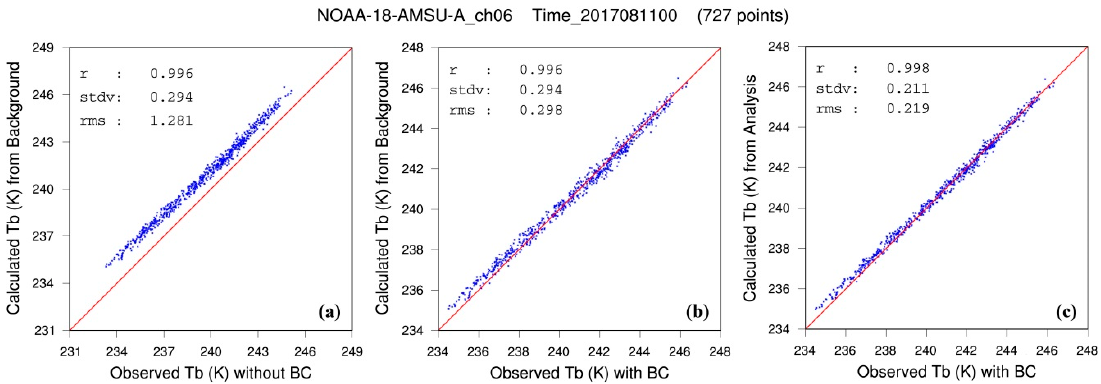
Figure 7. Scatter plots of the brightness temperatures (Tb) calculated from the background ( a ) without and ( b ) with BC and ( c ) the analysis versus observations for AMSU-A channel 6 of NOAA-18.